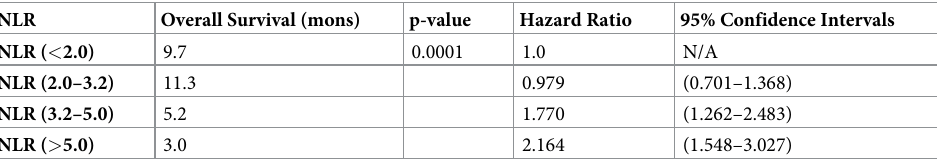
Table 6. The relationship between NLR (categorical variable) and